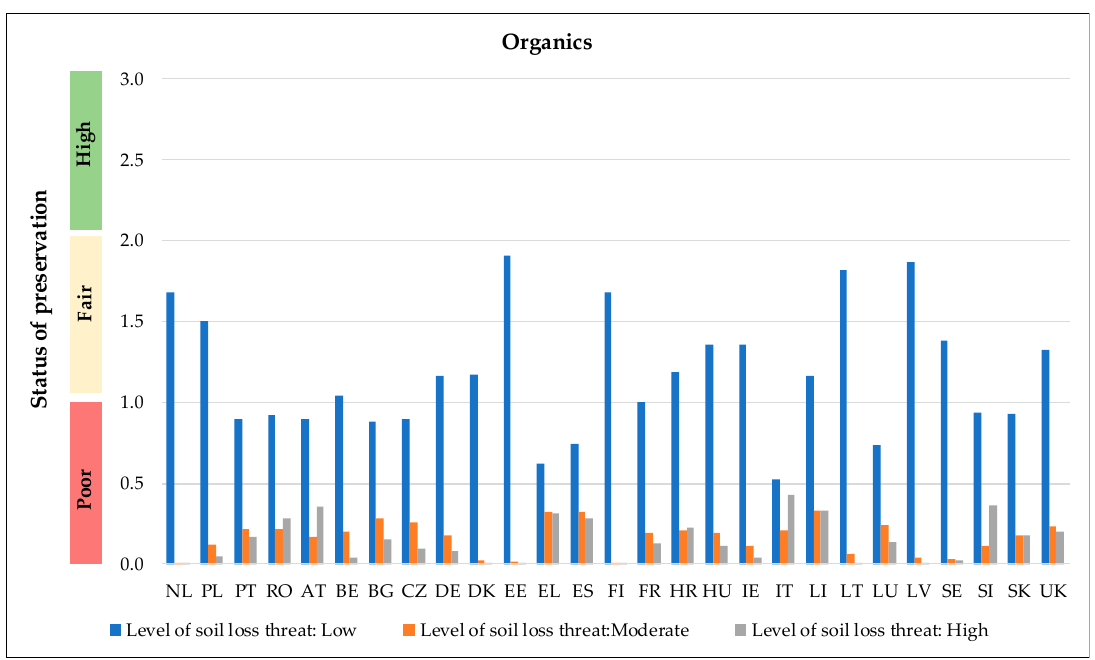
Figure 8. Mean values per country level for bones per level of soil-loss threats: Values close to 1 indicate poor status of preservation, values close to 2 indicate fair conditions of preservation, and values close to 3 good preservation status.